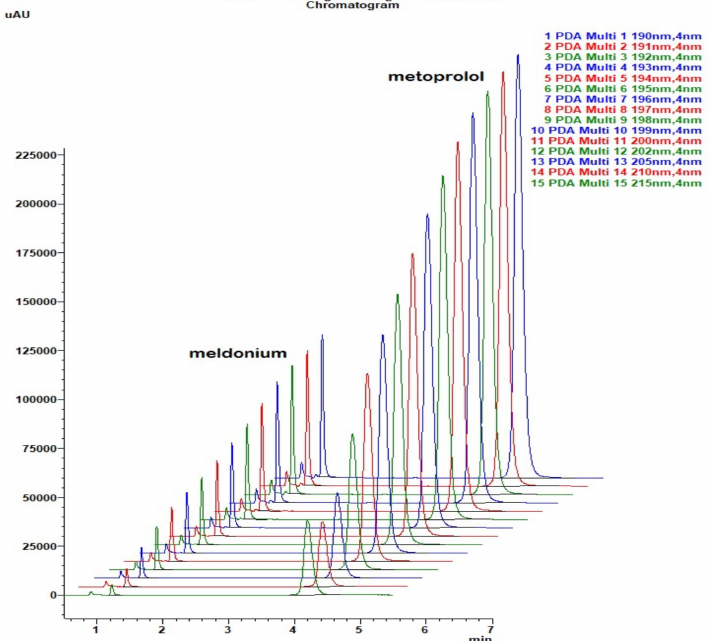
Figure 5. Chromatogram with LiChrospher CN 125 × 4 mm, mobile phase 20% ACN and 80% 13 mM NH 4 H 2 PO 4 , monitored and overlaid from 15-channels overlaid, depending on peaks sizes with increments of 1 nm in UV-wavelength. Both analyte peaks were highly sensitive to the change of the wavelength, significantly, thus directly influencing the method of sensitivity for both